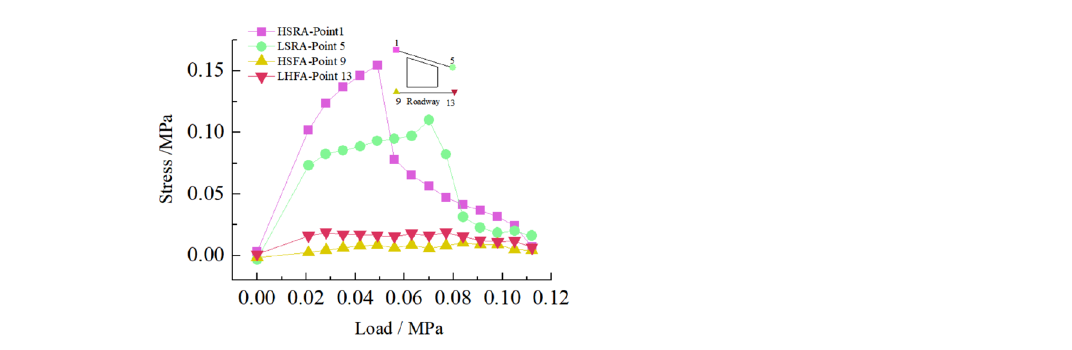
Figure 18. Curve of stress at sharp corner of roadway with